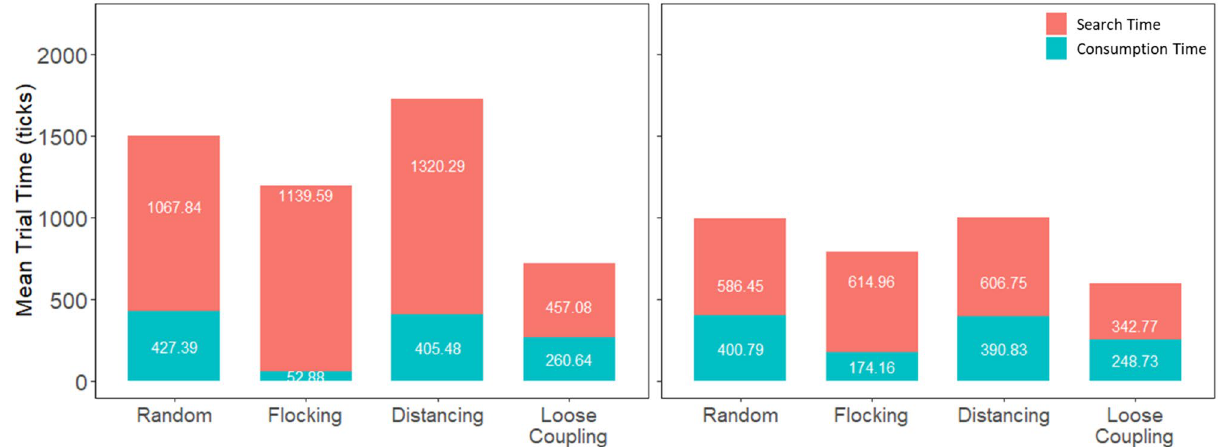
Figure 3. Mean trial time per session as a function of movement type without human intervention (left) and with human intervention (right). Mean trial times are divided into their composite search times (red) and consumption times